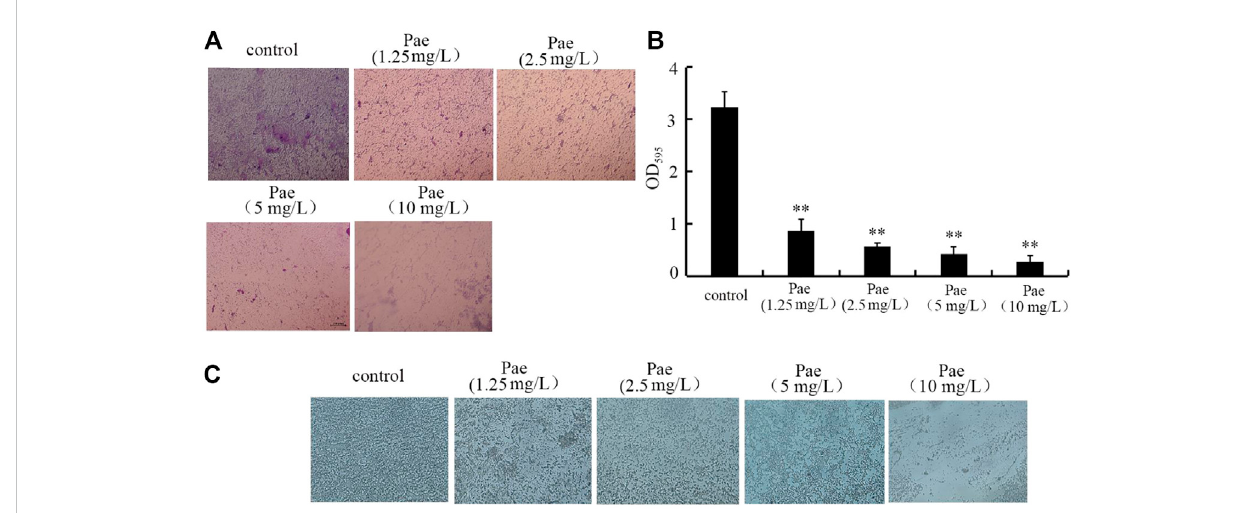
Effect of paeoni fl orin treatment on bio fi lm formation of P. aeruginosa PA14. (A) Crystal violate staining images. (B) Effect of paeoni fl orin treatment on amount of bio fi lm formation based on OD 595 absorbance analysis. (C) Effect of paeoni fl orin treatment on bio fi lm formation visualized under a light